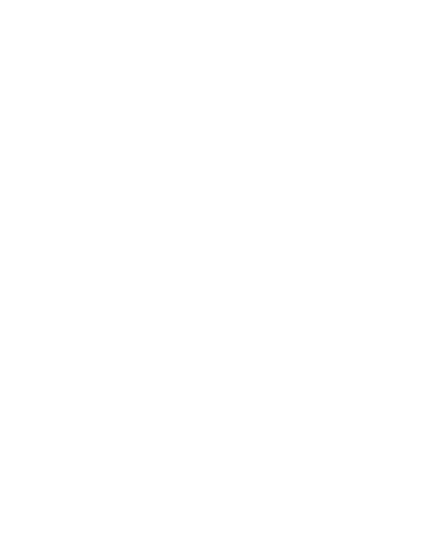
Table 1. Risk factors of the 18 selected